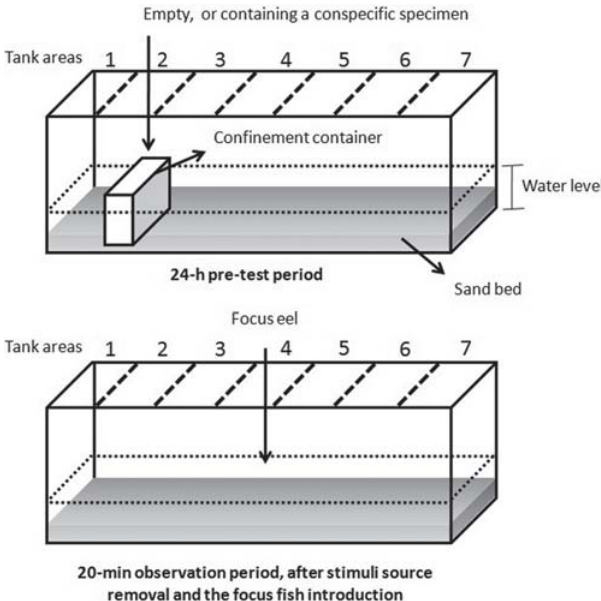
Fig. 1. Scheme of experimental apparatus during substrate odour labelling and eel’ spatial preference